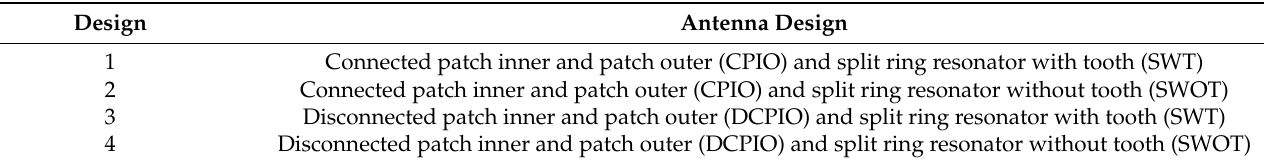
Table 1. Different proposed structures.